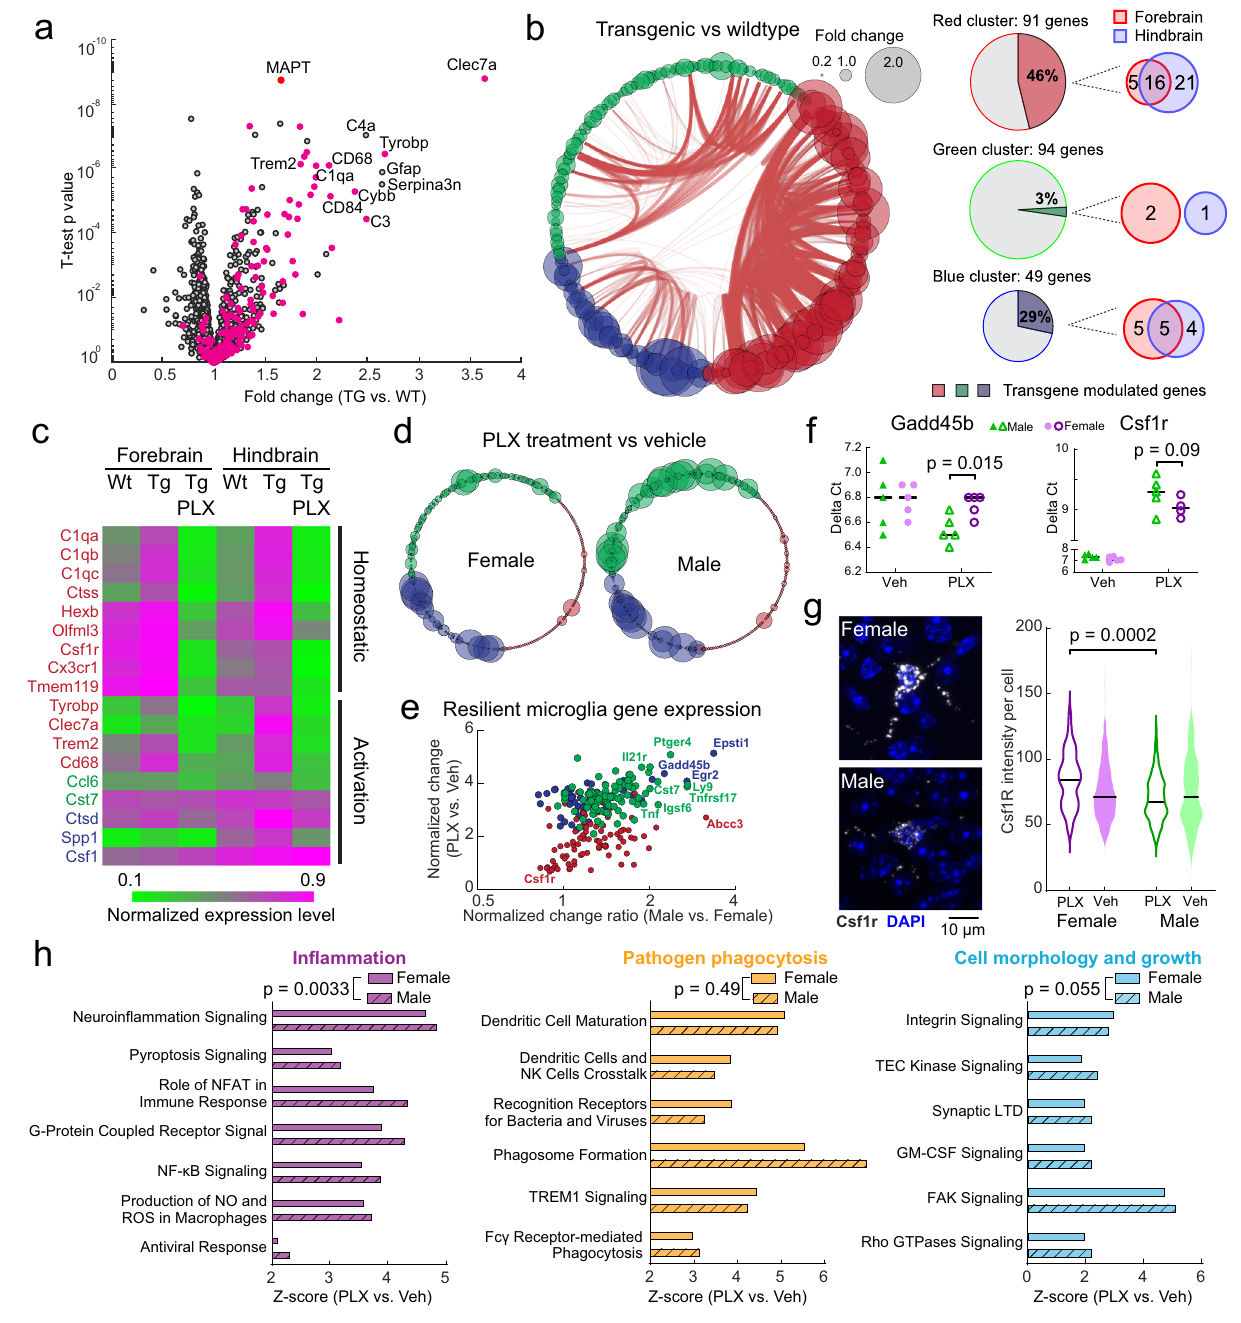
Fig. 10 | Selective ablation of tau-activated microglial gene expression by PLX5622.a VolcanoplotofgeneexpressionchangesbetweenTg2541andwildtype mice. Many microglial-speci fi c genes (magenta dots) show trends of up-regulation inTg2541mice.Two-sided t -testswereusedtocalculate P values. P valueswerenot corrected for multiple comparisons. b Schemaball graphs of microglial-speci fi c genes comparing Tg2541to wild type. Individual circle sizes indicate fold changes. Microglial-speci fi cgenes(242genesinourdataset)areclusteredintothreegroups: red, green and blue. Connecting arcs between genes represent the degree of cor- relation. The pie charts on the right show the percentage of genes in each group that are differentially expressed in Tg2541 and wild type mice, and the Venn dia- grams indicate the brain regions of differential expression. c Heatmap showing expressionlevelchangesinDAMgenes 51 .Genenamesarecolorcodedtoshowtheir group assignments. d Schemaball graphs of microglial-speci fi c genes comparing Tg2541 vehicle to PLX5622 treatment (1200mg/kg oral) in male and female mice.